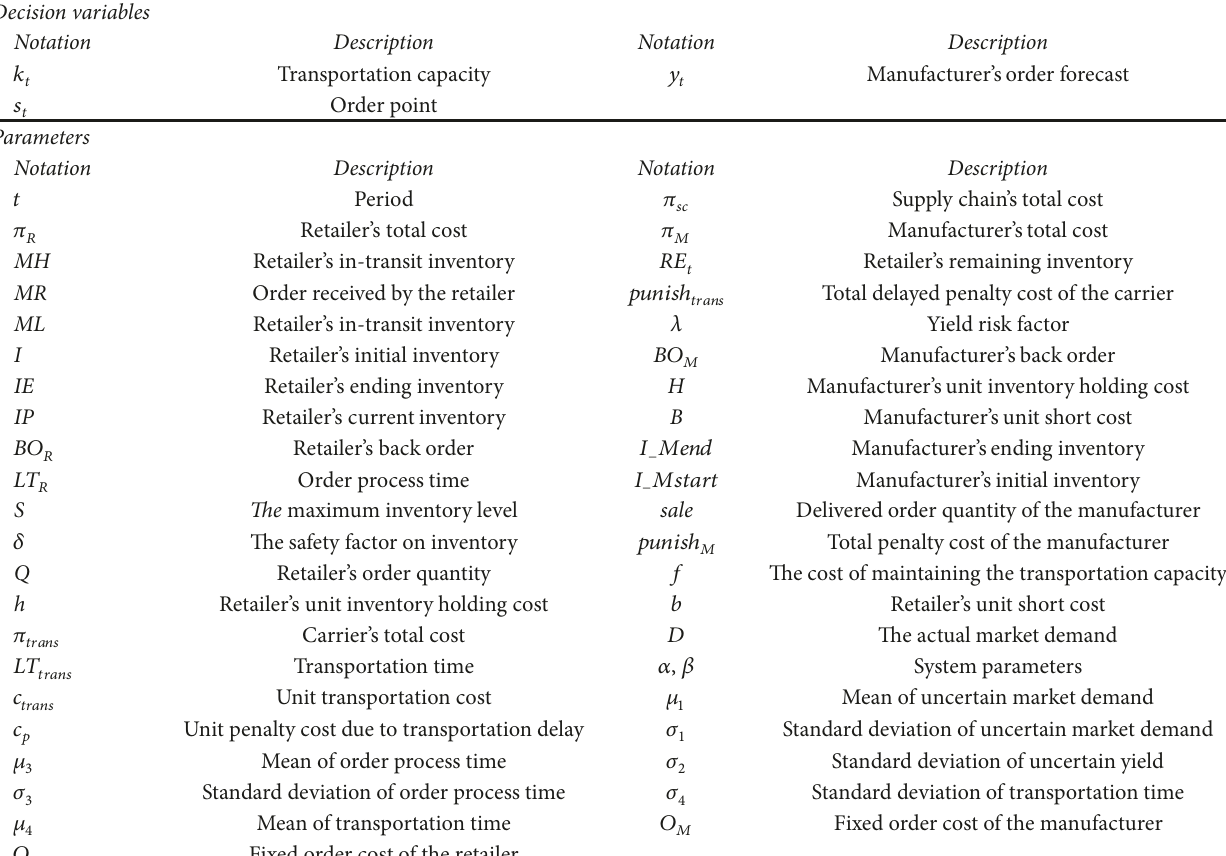
Table 1: The decision variables and parameters in the